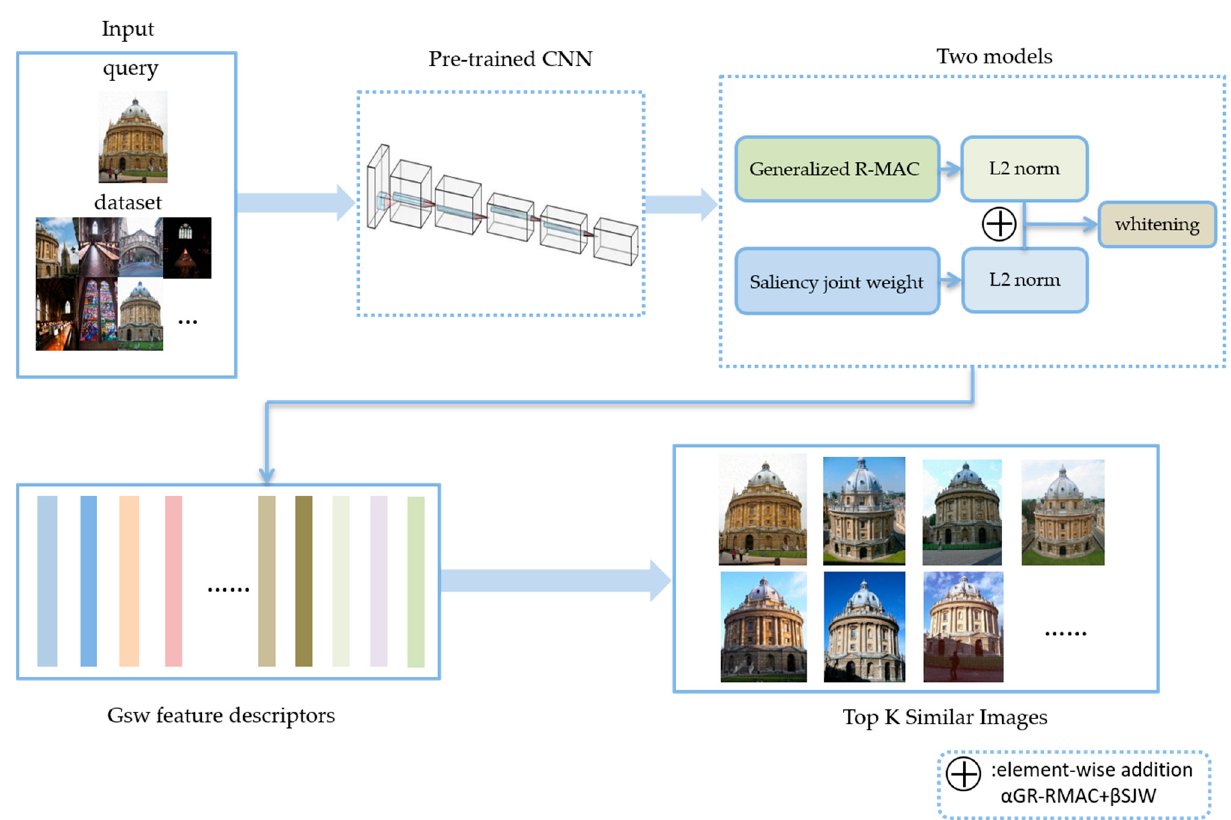
Figure 1. Global saliency-weighted deep convolution features for image retrieval. CNN, convolutional neural network; R-MAC, regional maximum activation of convolutions; GSW, global saliency weighted.